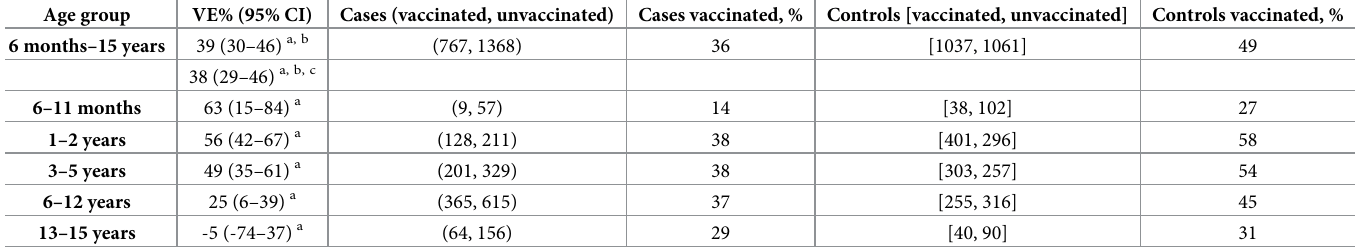
Table 2. Adjusted vaccine effectiveness (VE) of quadrivalent inactivated influenza vaccine for preventing influenza in the 2018/19 season (n = 4243). VE for pre- venting influenza A (N = 4243). Age group